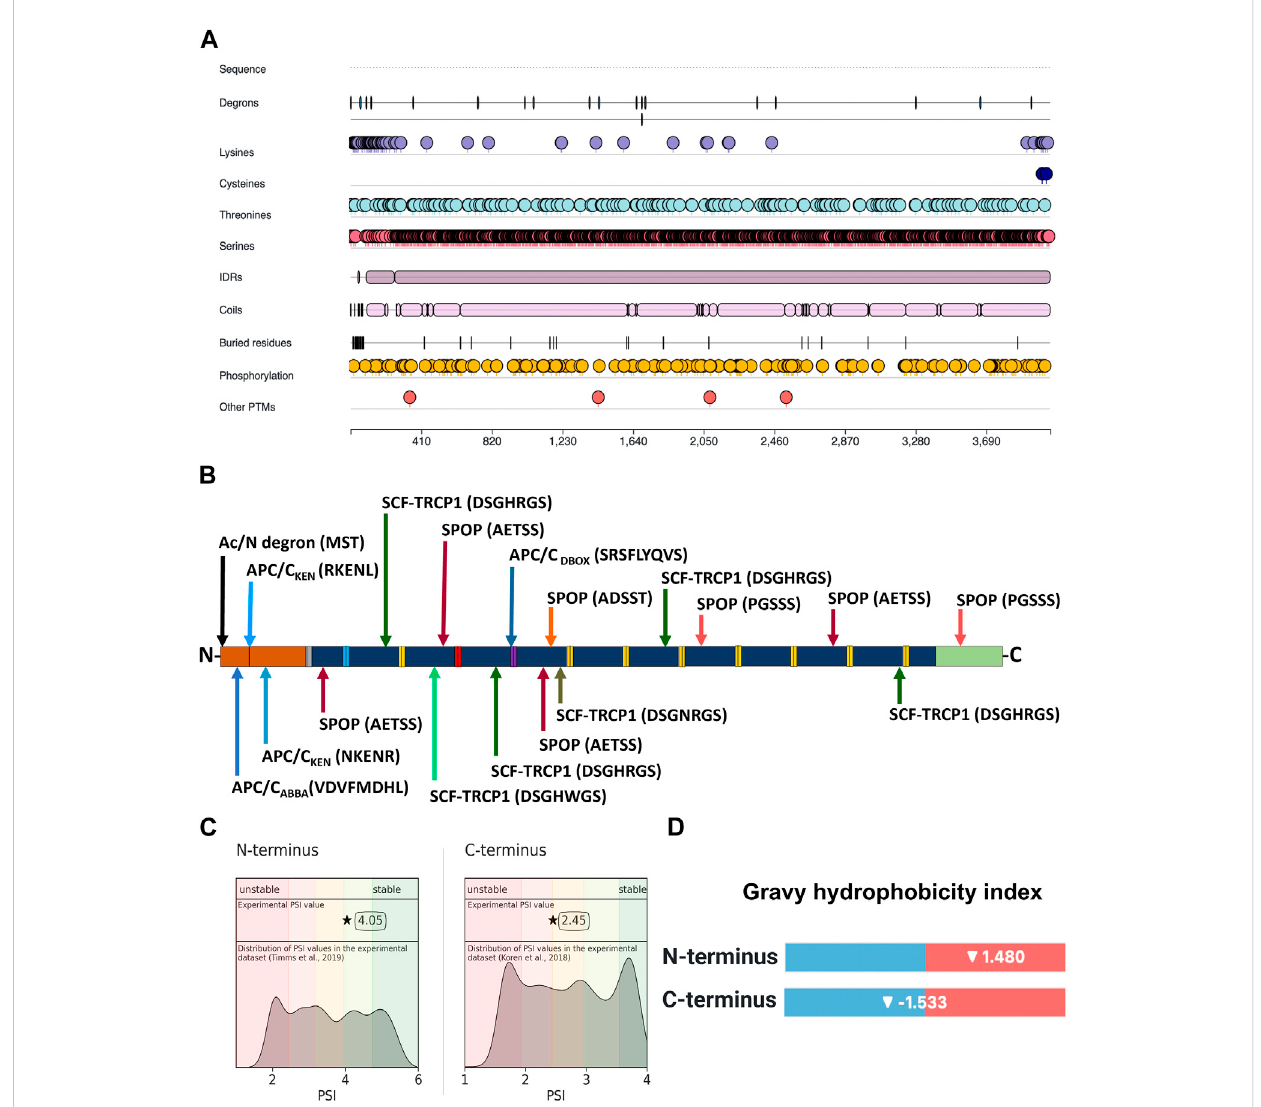
FIGURE 2 Locationofdegronmotifs,ubiquitination-proneresidues,andterminalstabilityofpro fi laggrin. (A) Illustrationshowinglocationofdegron,ubiquitin- conjugatingaminoacidresidues,intrinsicdisorderregion,phosphorylationsitesandotherpost-translationalmodi fi cationsitesinthepro fi laggrinprotein. (B) Location ofdegronmotif sequenceand degron typeinthepro fi laggrin wild-type sequence (legendas ofFigure 3); (C) proteinstability indexof theN- and C- terminus of the pro fi laggrin; (D) Gravy hydrophobicity index of pro fi laggrin N- and C